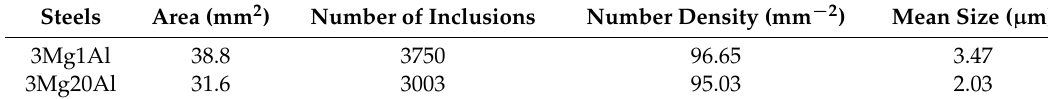
Table 2. Statistical results of inclusions in experimental steels.